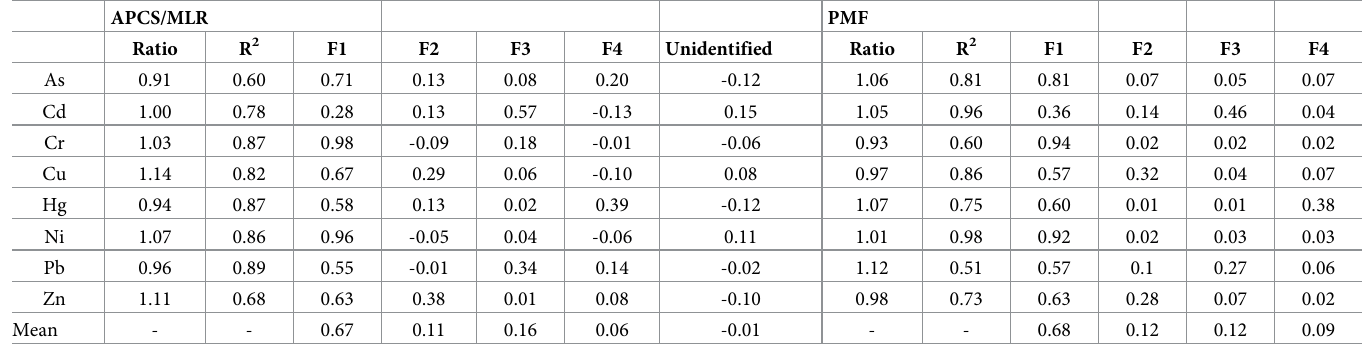
variation and had a highly positive loading of Cu and a moderate loading of Zn. F3 explained 17.64% of the total variance and had a highly positive loading of Pb and a moderate loading of Cd. F4 accounted for 15.88% of the total variance and a highly positive loading of Hg. The contributions of different factors were calculated using the APCS/MLR receptor model (Table 3). The accuracy of APCS/MLR was assessed via the R 2 and predicted/observed values. The R 2 parameters varied between 0.60 and 0.89, and the predicted/observed values ranged from 0.91 to 1.14, indicating that the APCS-MLR model had high accuracy. F1 primarily con- tributed to As, Cr and Ni with values of 71%, 98% and 96%, respectively. F2 dominated Cu (29%) and Zn (38%). F3 explained the 57% of Cd and 34% of Pb variations, and the six other potentially toxic elements had positive values. F4 explained 39% of Hg. However, the APCS exhibited a component that was not accounted for, i.e., the intercepts of the regressions, which ranged from -12% to 15%. The mean of the eight potentially toxic elements represented four factors, and the contributions of the four factors to potentially toxic element pollution in the study area were 67%, 11%, 16% and 6%. In the PMF model, the number of optimal factors was determined to be four through train- ing experiments, which is consistent with the APCS/MLR results. The results of the PMF model are shown in Table 4, and the Q (robust) value was 12723.8. All potentially toxic ele- ments in the PMF model had a high correlation, with R 2 > 0.51 and 0.93 < Ratio (Predicted/ Observed) < 1.12. Cr, Cu, Hg, Ni and Zn had the highest correlations in F1, which dominated the contribution and presented values ranging from 51% to 94%. Cu had the highest concen- tration in F2 and accounted for 32%, and Zn represented 28% of the content related to F2. F3 influenced Cd (46%) and contributed to Pb with values of 28%. F4 had the strongest contribu- tion to Hg (38%). The mean of the eight potentially toxic elements represented four factors, and the contributions of the four factors to potentially toxic element pollution in the study area were 68%, 12%, 12% and 9%. Overall, the grouping of potentially toxic elements from the APCS and PMF models were similar and exhibited comparable factor contribution rates.